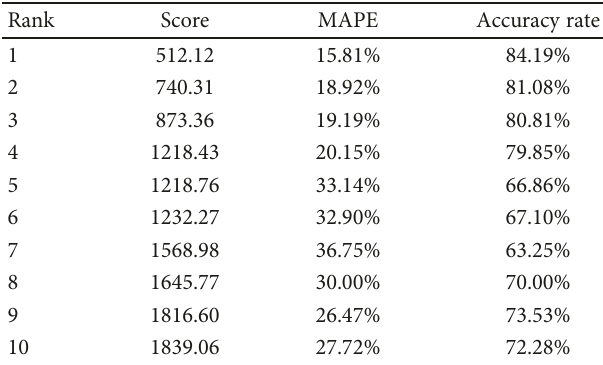
Table 7: Engine life prediction accuracy of the 2008 PHM data